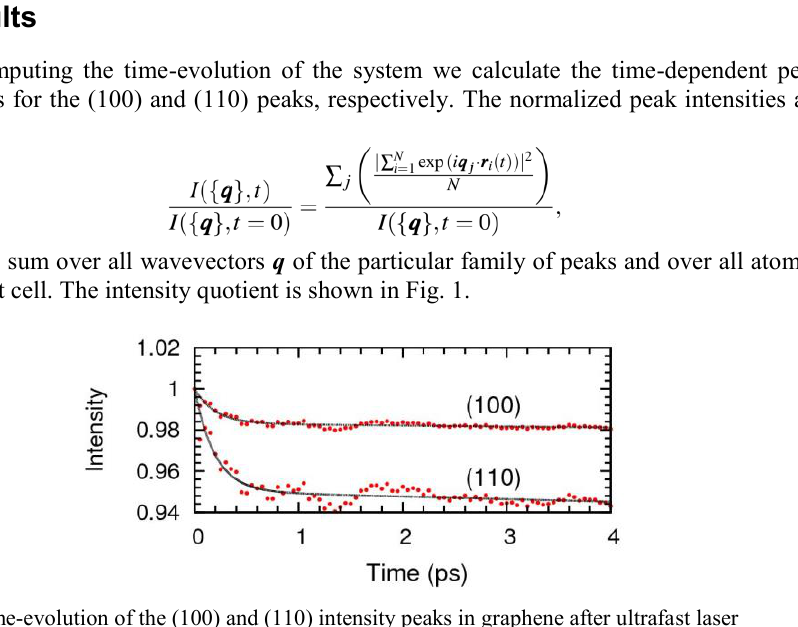
Fig. 1. Time-evolution of the (100) and (110) intensity peaks in graphene after ultrafast laser excitation. Red dots refer to the ab-initio simulations and the black lines to the fitted